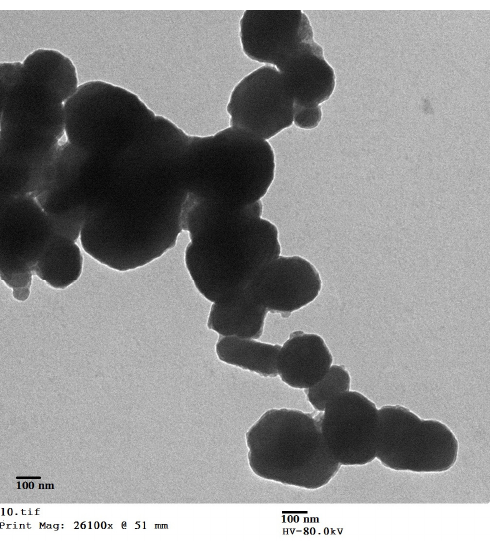
Figure 4. Transmission electron microscopy (TEM) image of the biosynthesized TiO 2 NPs .